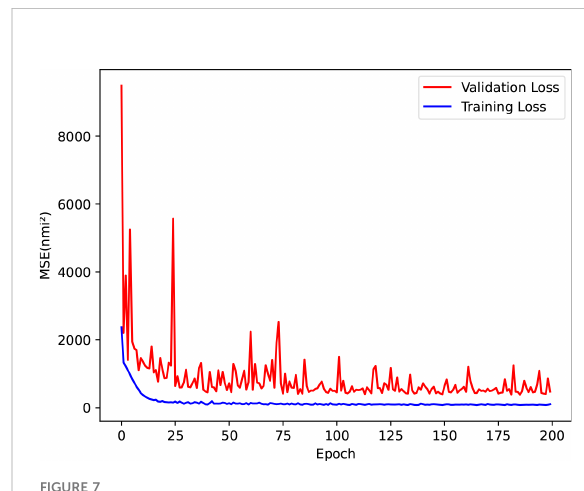
FIGURE 7 Plot of the decreasing loss values of the model on the training and validation sets. An epoch indicates that all training samples are computed in the model once in full and MSE indicates mean squared